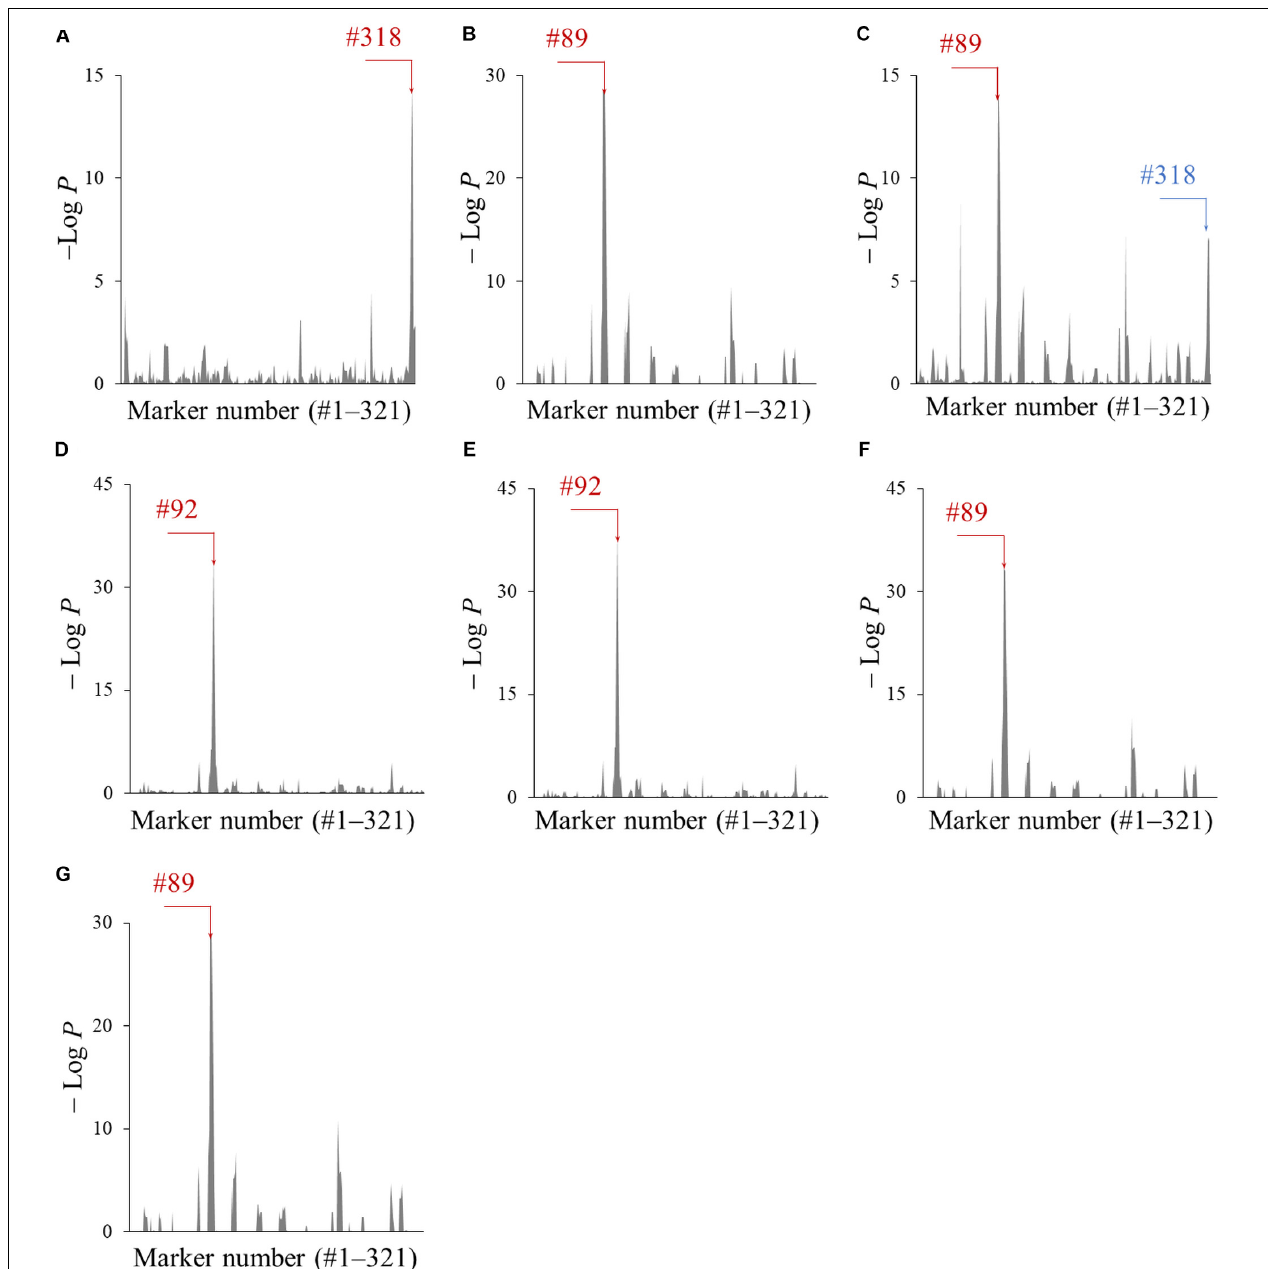
FIGURE 4 | The association of genomic segments of Peking with the amounts of metabolites A–G (A–G) . The − Log P values obtained by the ANOVA was plotted against the corresponding 321 markers. The markers with the largest − Log P values are indicated with red arrows and the marker number (#). The marker which was associated with amounts of metabolite C is indicated by a blue arrow and the marker number